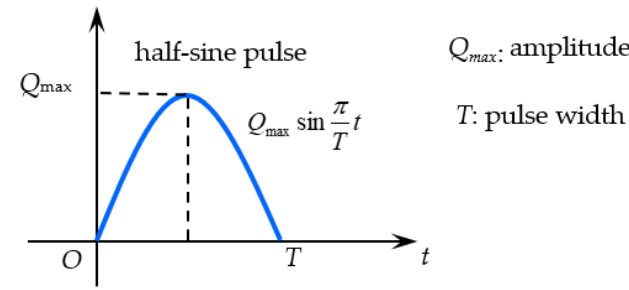
Figure 2. Expression for harmonic